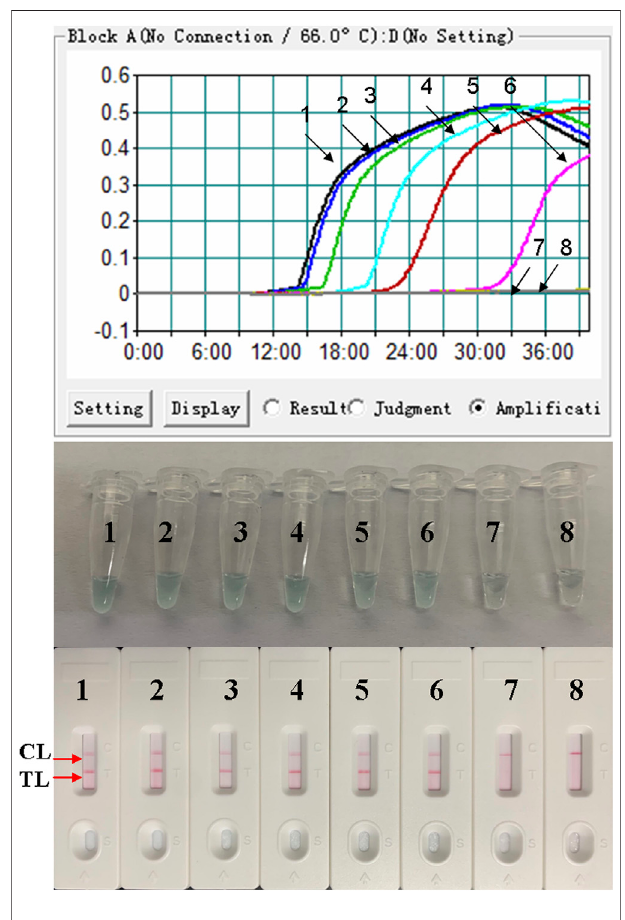
FIGURE 4 | Sensitivity con fi rmation of the Bordetella pertussis loop- mediated isothermal ampli fi cation (LAMP) assay. The sensitivity of the assay was analyzed using 10-fold serial dilutions from 5 ng to 5 fg per reaction. The LAMP reactions with various levels of DNA templates were recorded with turbidity curves, and the products were indicated by a visual detection reagent (VDR) and a nanoparticle-based lateral fl ow biosensor (LFB). Turbidity curves/tubes/strips 1 – 7 represent different concentrations ofDNA: 5 ng; 500, 50, and 5 pg; and 500, 50, and 5 fg per reaction. Turbidity curve/tube/strip 8 represents the blank control. TL , test line; CL , control